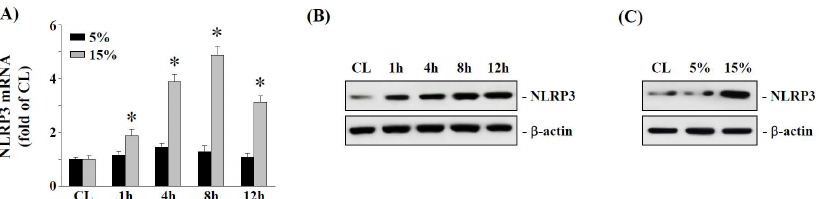
Figure 1. HCS upregulates NLRP3 expression in human AF cells (HAFCs). ( A , B ) HAFCs were exposed to 5% or 15% HCS for the indicated times, and the expression levels of NLRP3 mRNA ( A ) were determined by real-time PCR analysis. The results are mean ± standard error of the mean (SEM). The protein expressions of NLRP3 were determined by Western blot analysis ( B ). ( C ) HAFCs were kept as controls (CL) or exposed to 5% or 15% CS for 8 h, and the protein expressions of NLRP3 were determined by Western blot analysis. Bars in ( B , C ) are the mean and SEM fold change in band density relative to control, normalized to total protein levels from three independent experiments. * p < 0.05 versus CL.